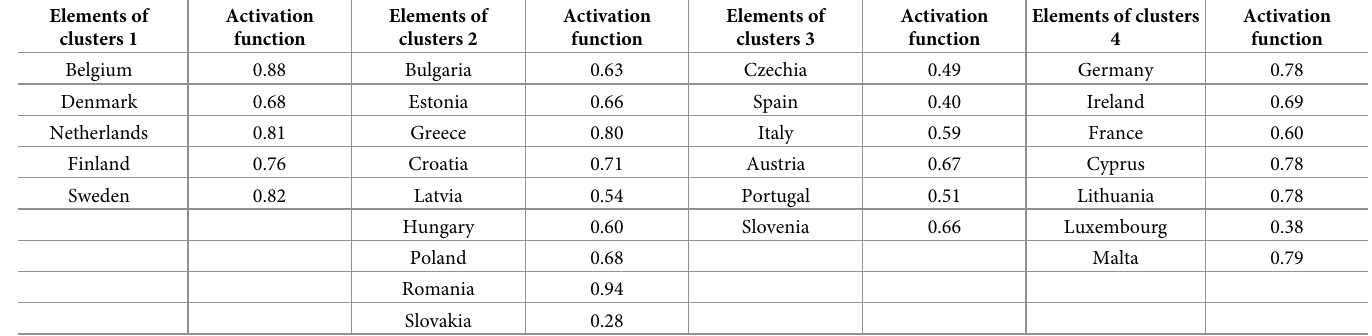
Table 9. The division of the EU countries into similar groups based on the examined indicators for medium-sized enterprises together with activation values (dis- tance from the center of the cluster). Elements of clusters